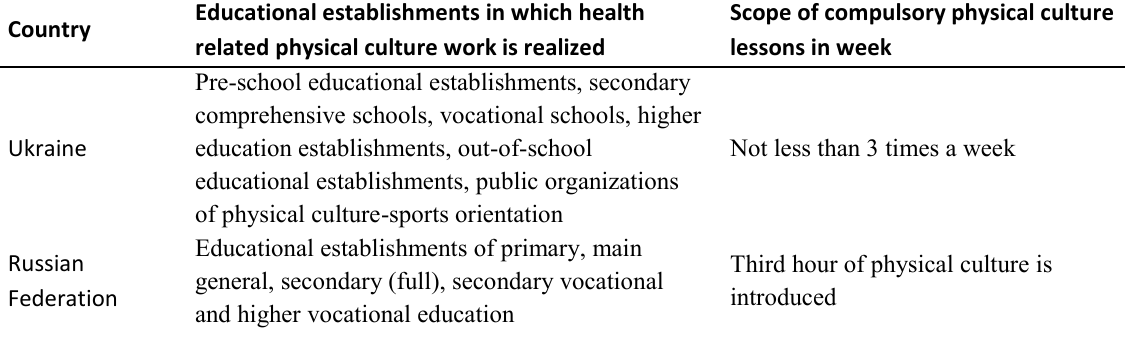
Table 2. Organization of physical culture in educational establishments of different countries Т